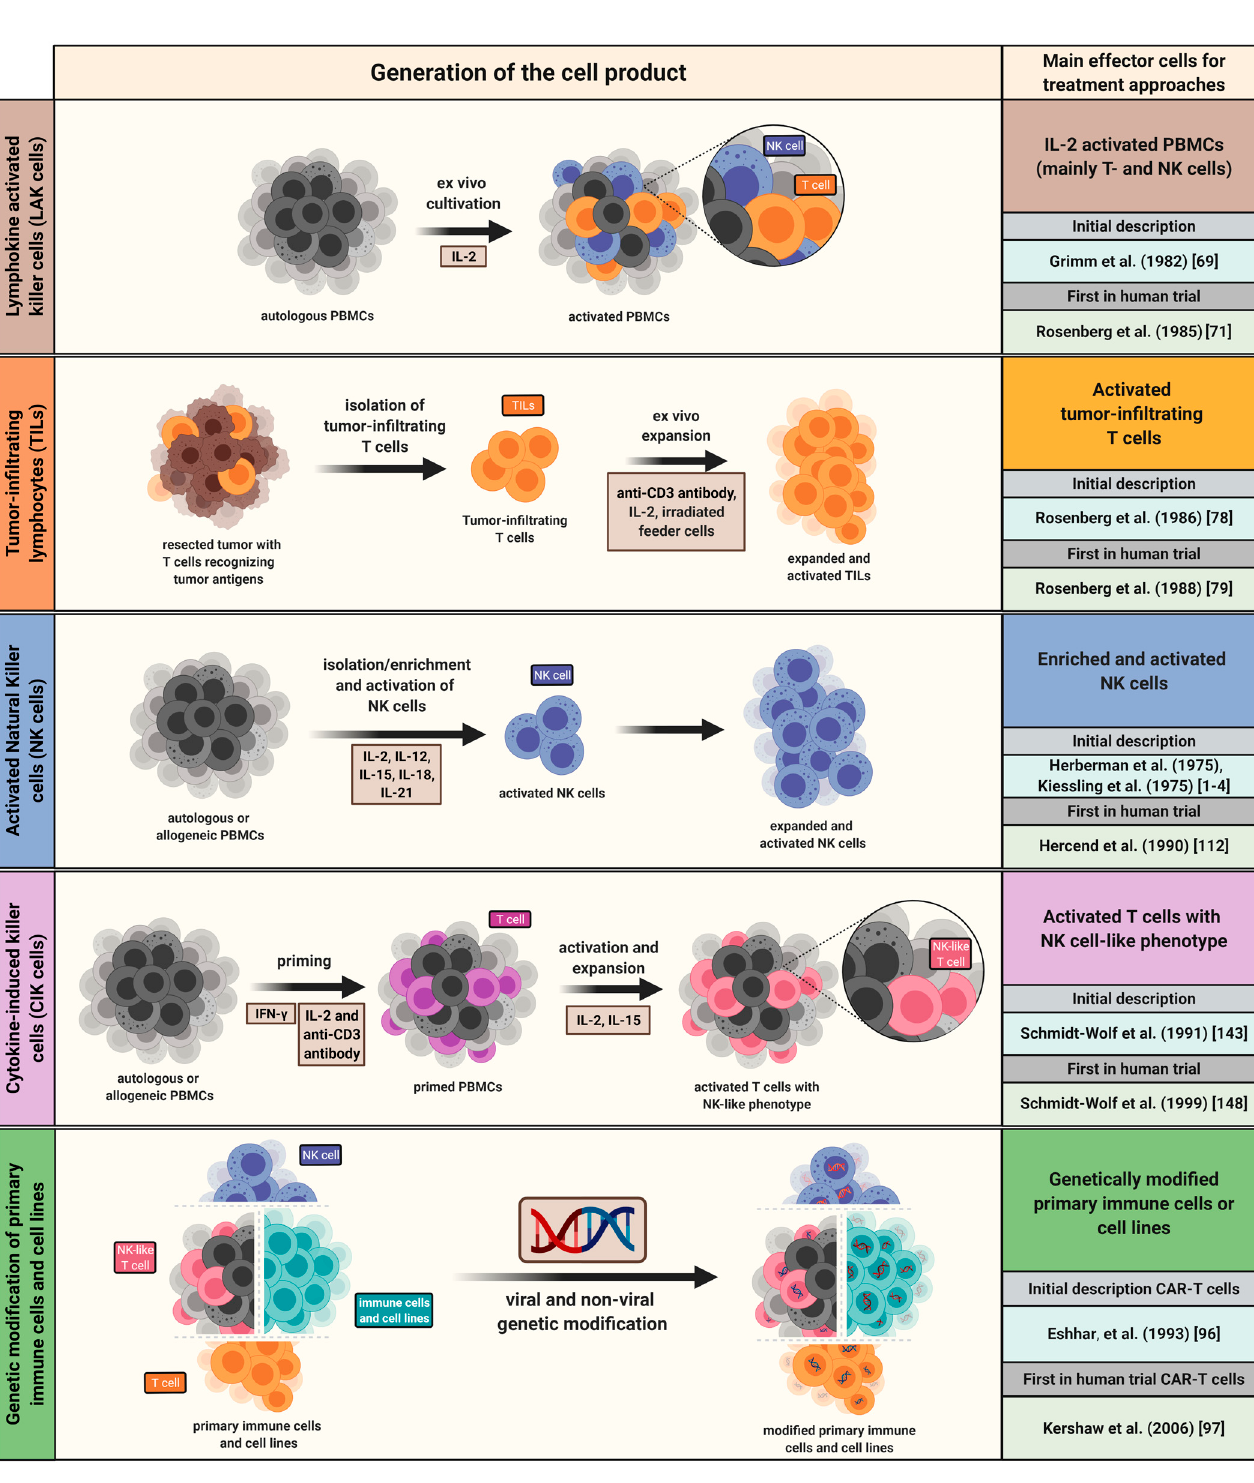
Figure 2. Generation of immune cell products for application in cancer therapy. Overview of exemplary cell sources and procedures for the generation of representative immune cell products. Additionally, time points of discovery and initial application in clinical trials are indicated. Alternative cell sources are possible for specific immune cell products. INF- γ = Interferon- γ ; PBMC = peripheral blood mononuclear cells.